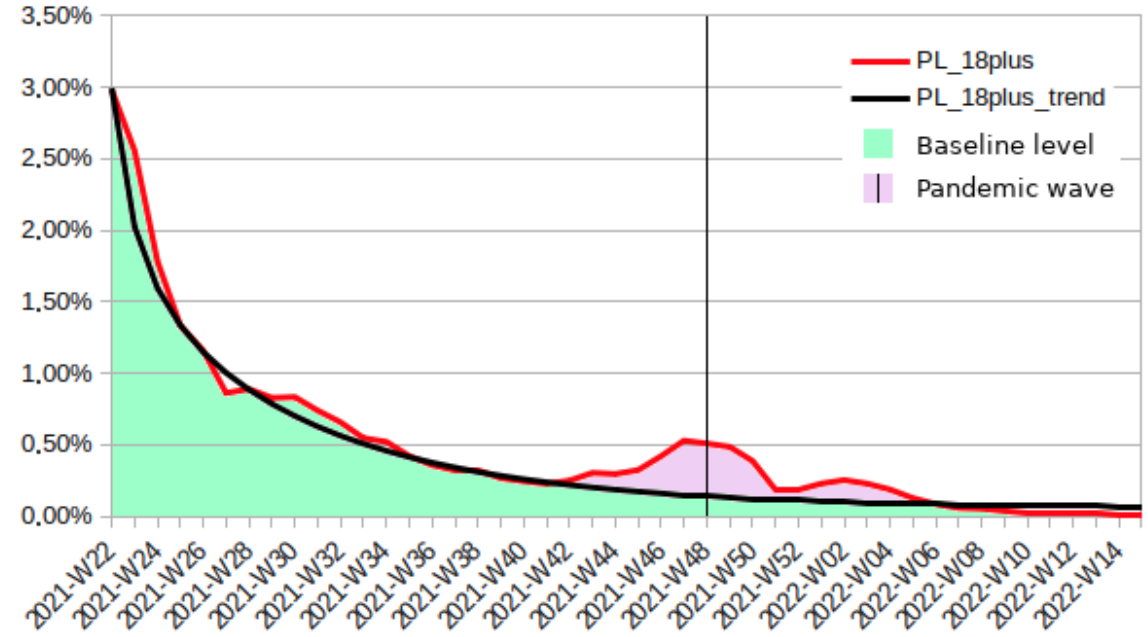
Figure 2. Percentage of Polish adult population that received the first dose of COVID-19 vaccine in the period 2021-W22 to 2022-W15, subdivided into groups according to different implied motivation mechanisms.